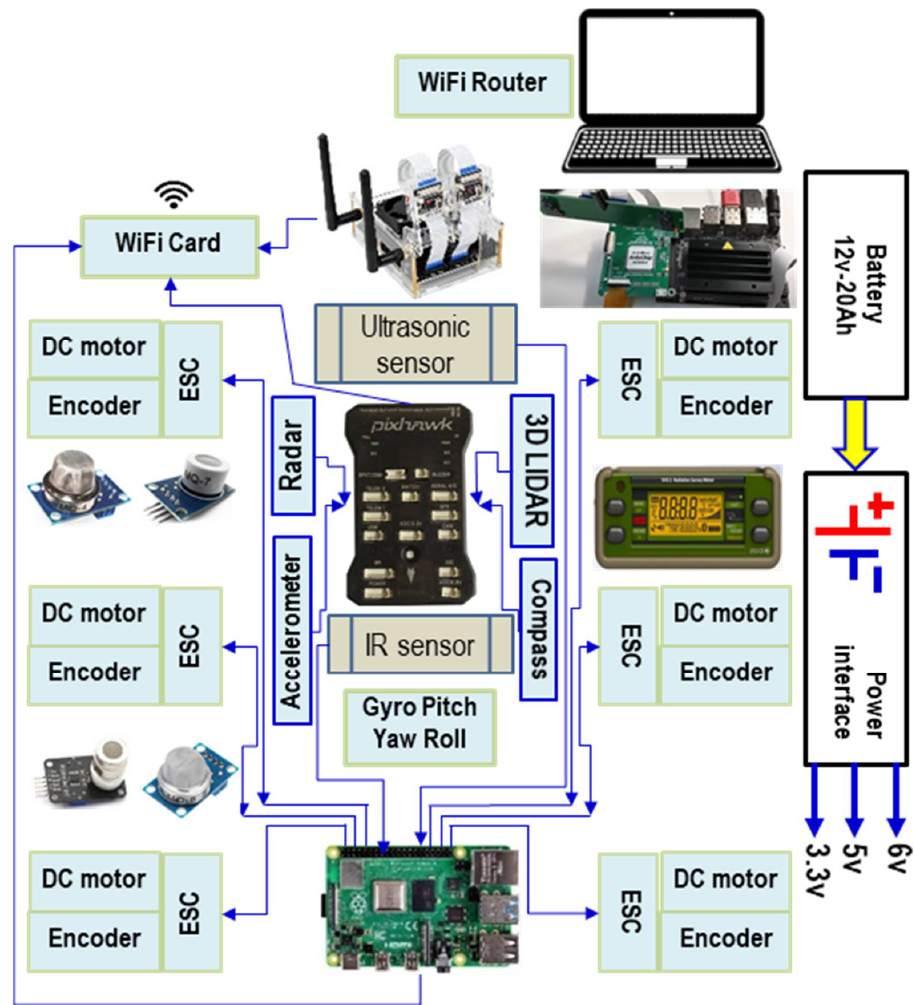
Figure 3. The control and command architecture of the studied robot including obstacle detection (ultrasonic and infrared (IR) sensors); orientation (tri-axial accelerometer and global positioning system (GPS)), gyroscope (pitch, yaw, and roll), compass; DC motor encoder, Electronic Speed Controller (ESC); Pixhawk controller, Raspberry Pi 4 controller and NVIDIA Jetson Nano; power system, and Wi-Fi communication system.